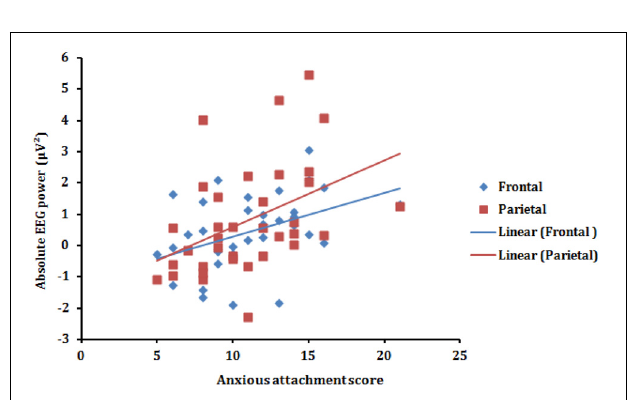
theta absolute powers from A to T condition is shown for high anxious (HA) attached participants. No significant difference across all frequency bands was detected between A and T conditions for low anxious (LA) attached participants.